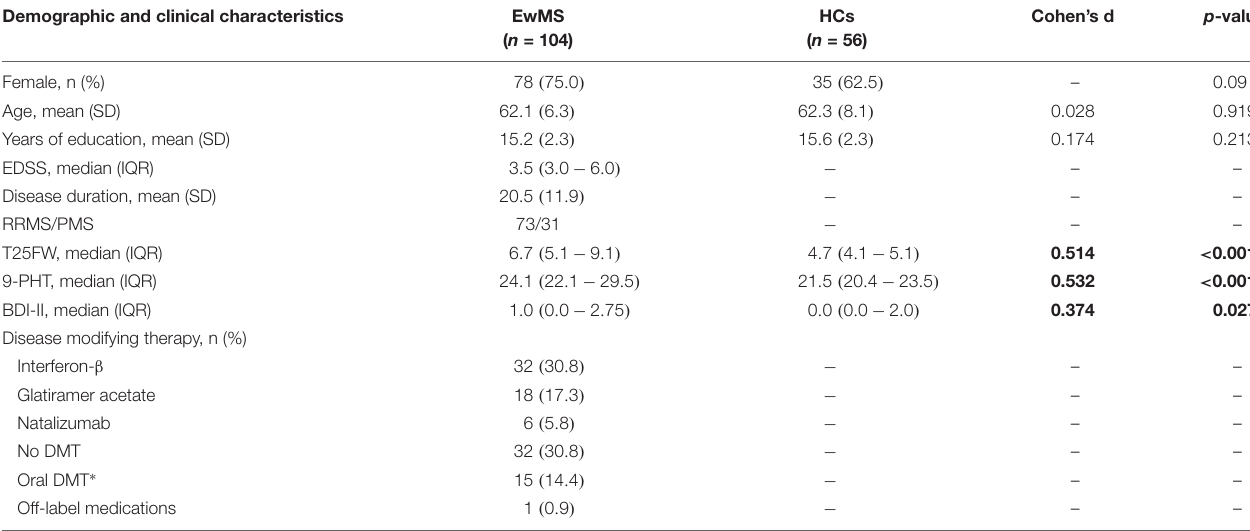
TABLE 2 | Demographic and clinical characteristics of the EwMS and HCs samples. Demographic and clinical